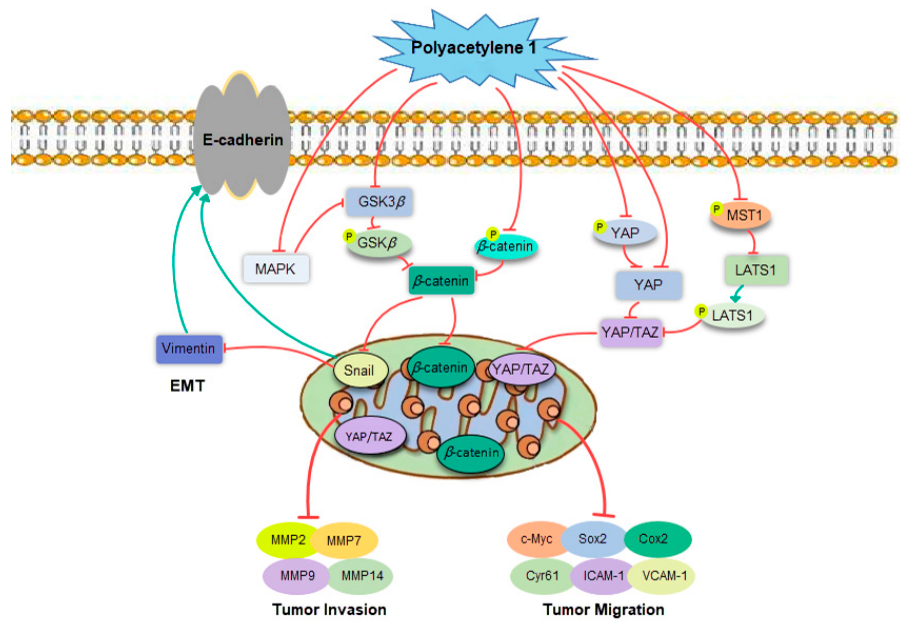
Figure 9. Polyacetylene 1 regulated tumor invasion and migration via various signaling